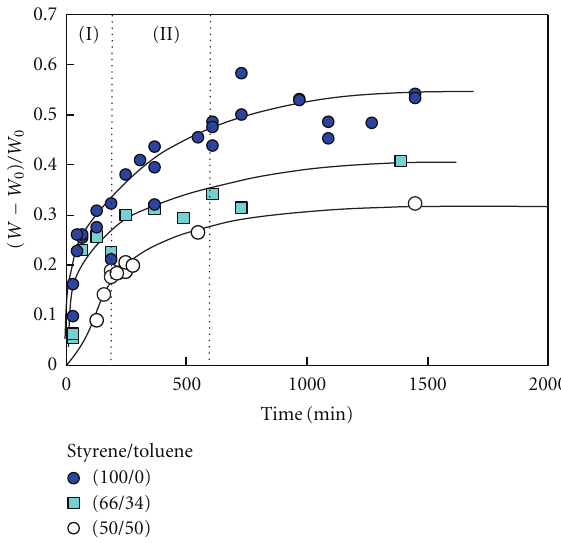
Figure 4: Graft polymerization ratio ( W − W 0 /W 0 ) as a function of polymerization time ( t ), determined for mixed solvent of styrene/toluene (100/0), (66/34), and (50/50) (wt/wt), respectively (solid lines are guides for